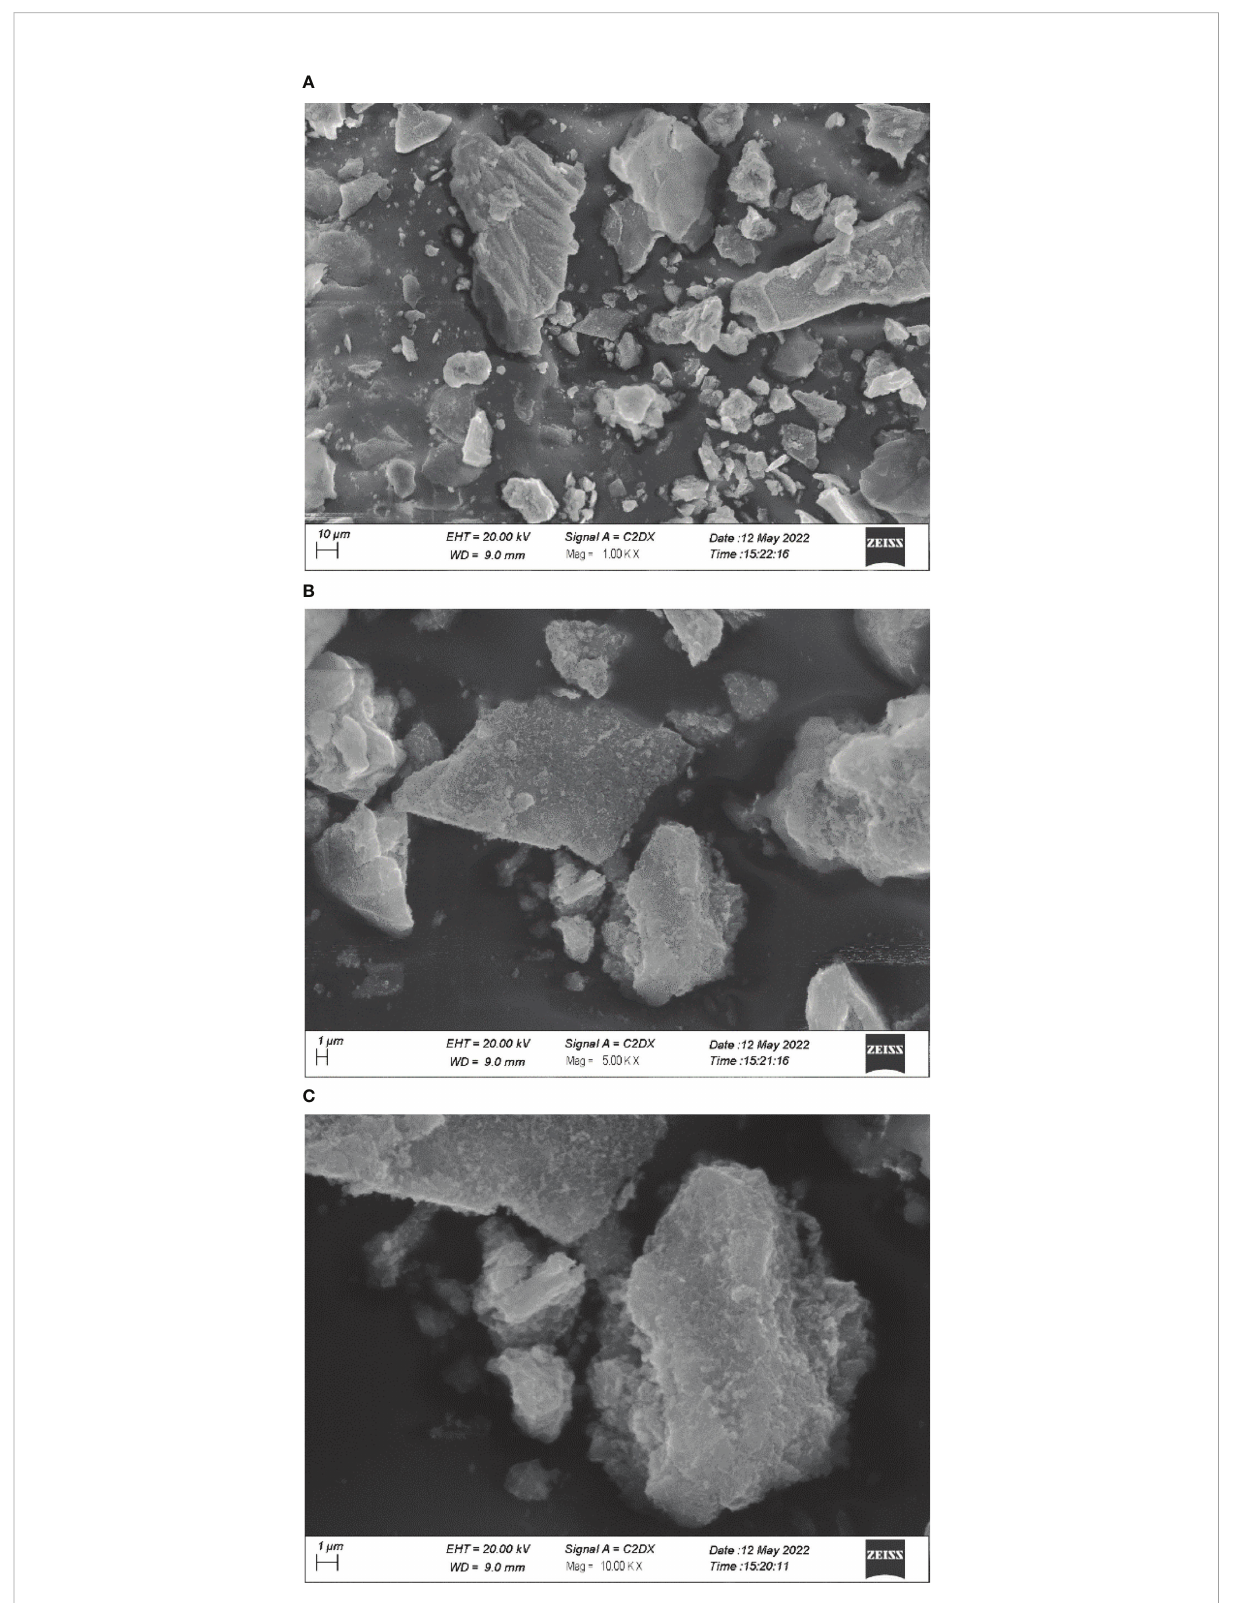
FIGURE 5 SEM images of graphene oxide nanoparticles under different magni fi cations (A) 1 KX; (B) 5KX; (C)